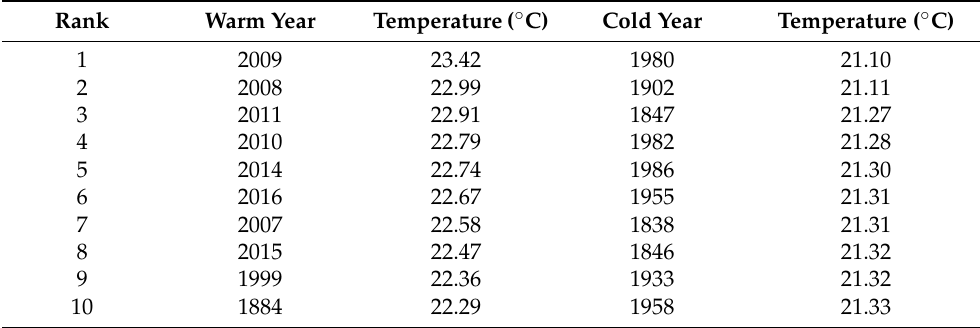
Table 2. The top 10 warmest and coldest years of the pMar-pOct mean temperature reconstruction during